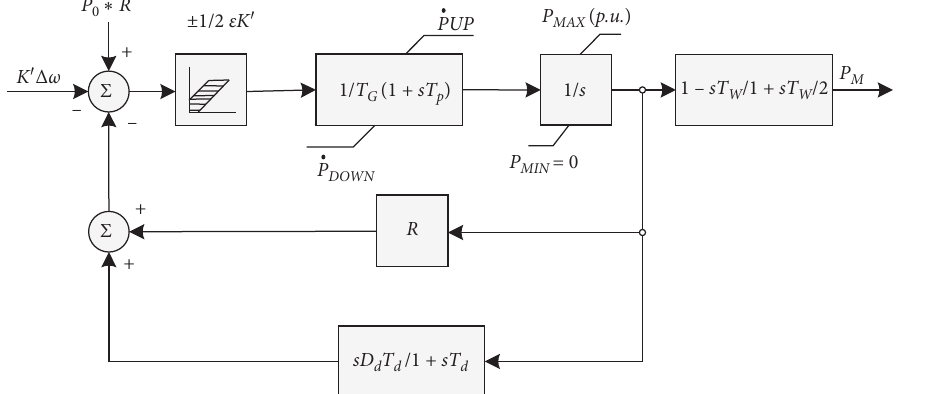
Figure 8: Typical structure of the turbine governor and prime mover model.